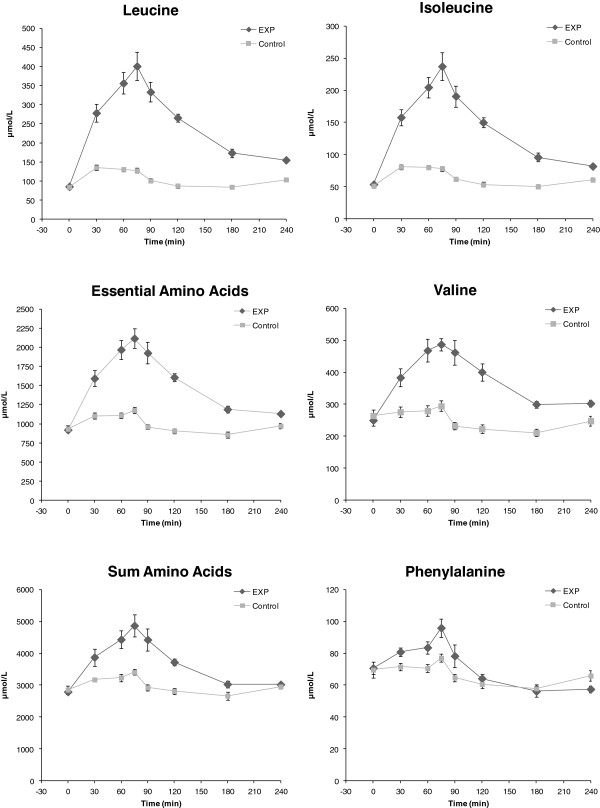
Plasma amino acids. Plasma concentrations (means ± SEM) of leucine, essentials amino acids (EAA), sum of amino acids (AA), isoleucine, valine and phenylalanine before and after ingestion (at T = 0) of the study products EXP (n = 9) and Control (n = 10). Baseline values were not different between groups. iAUC values for leucine, EAA and AA were significantly higher after ingestion of EXP vs Control (P < 0.001). For leucine and EAA, peak and change-from-baseline concentrations were also significantly higher after ingestion of EXP vs Control (P < 0.001).